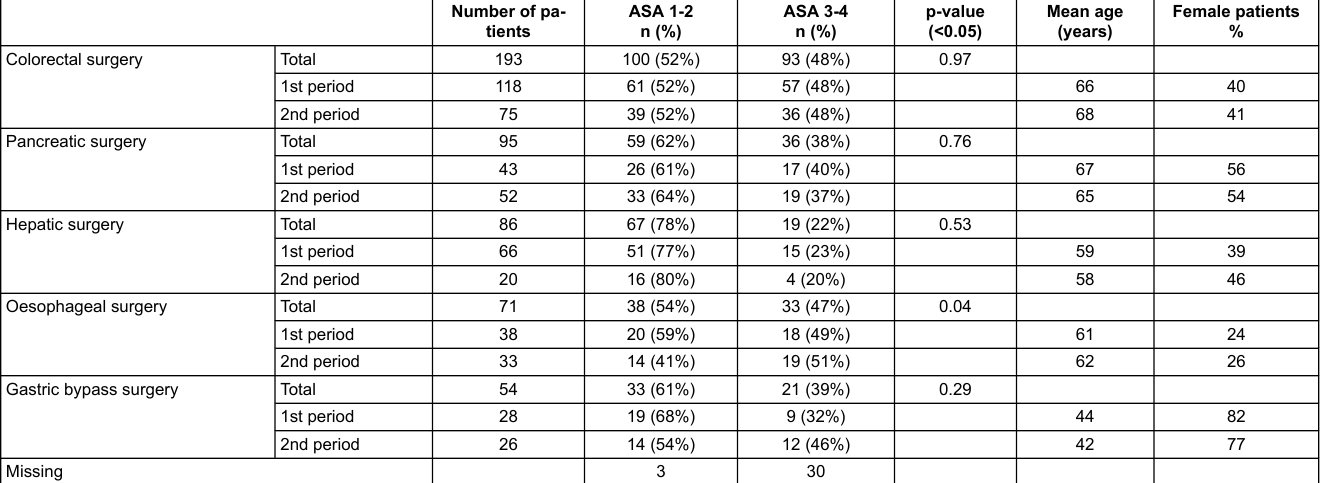
Table 1: ASA scores of the patients.